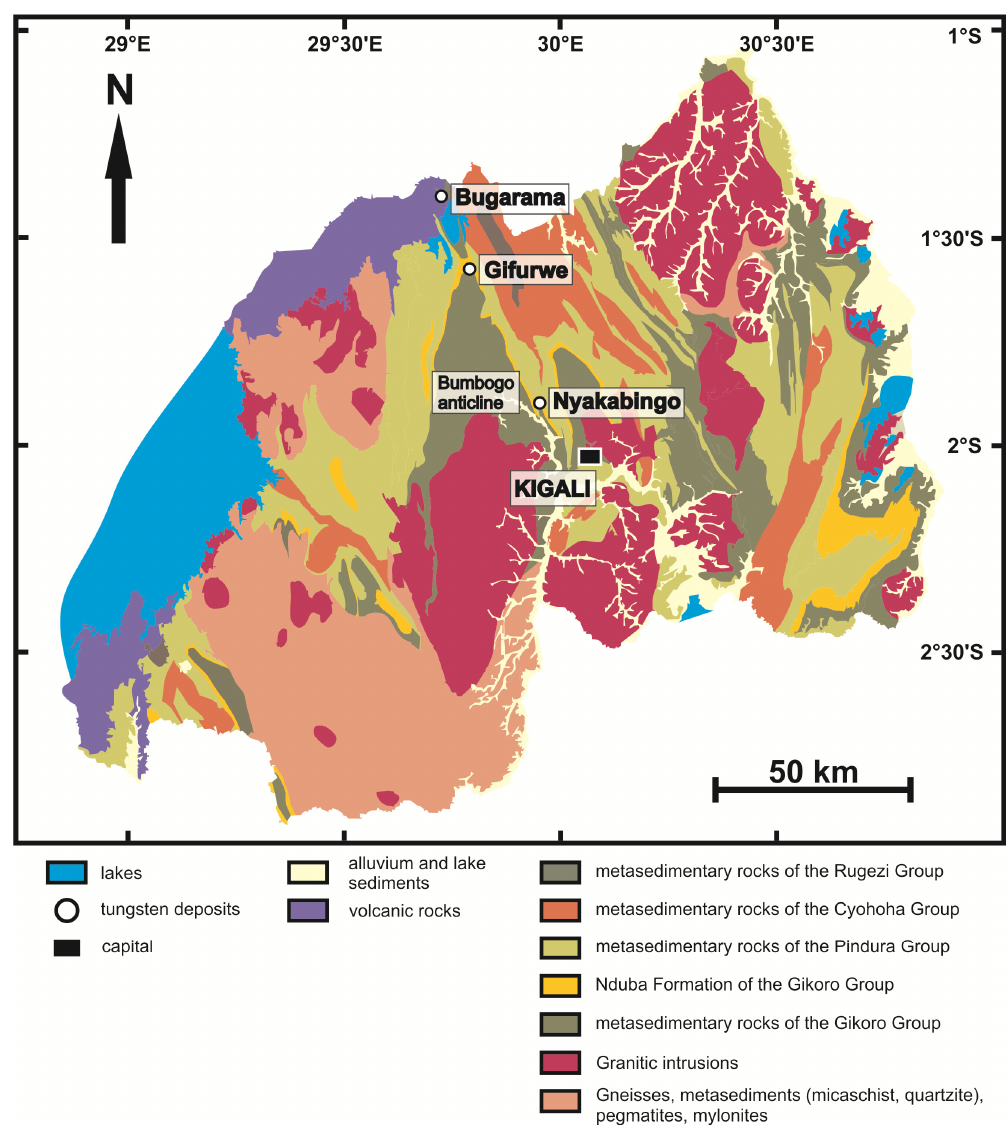
Figure 1. Geological map of Rwanda showing the tungsten deposits of Nyakabingo, Gifurwe and Bugarama (modified after